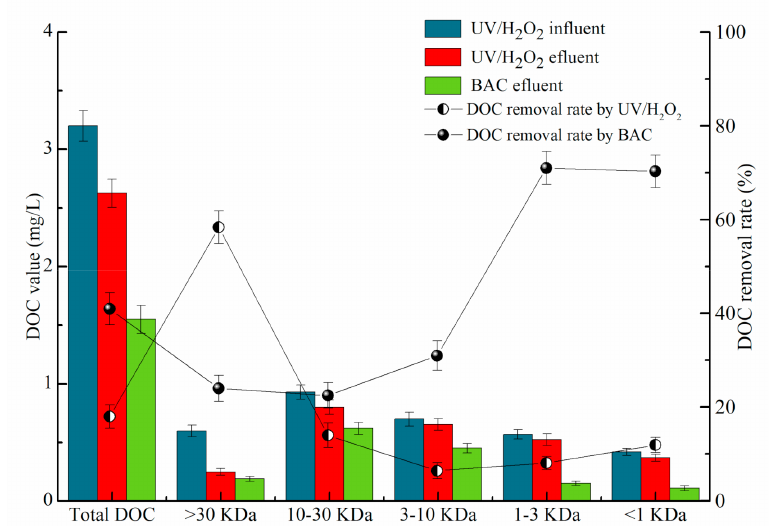
Figure 4. Change of molecular weights distribution of UV/H 2 O 2 -BAC